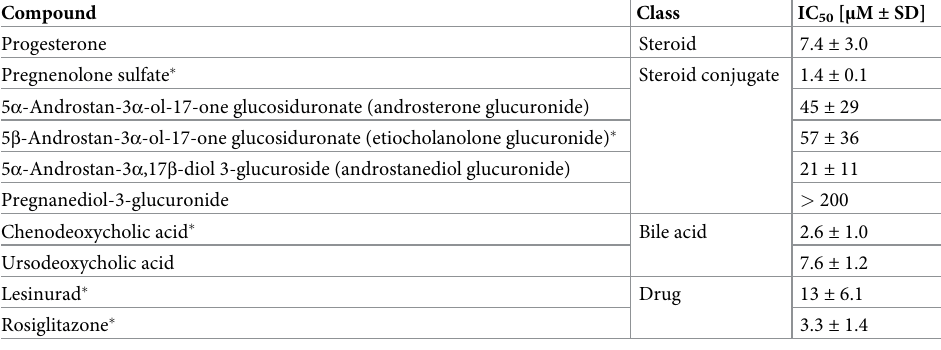
Table 3. Inhibition potencies of steroid, steroid conjugates, bile acids and drugs for SLC22A24-mediated tauro- cholic acid uptake. The experiments were repeated at least once to obtain IC 50 mean ± SD (the inhibition concentra- tion at 50% taurocholic acid